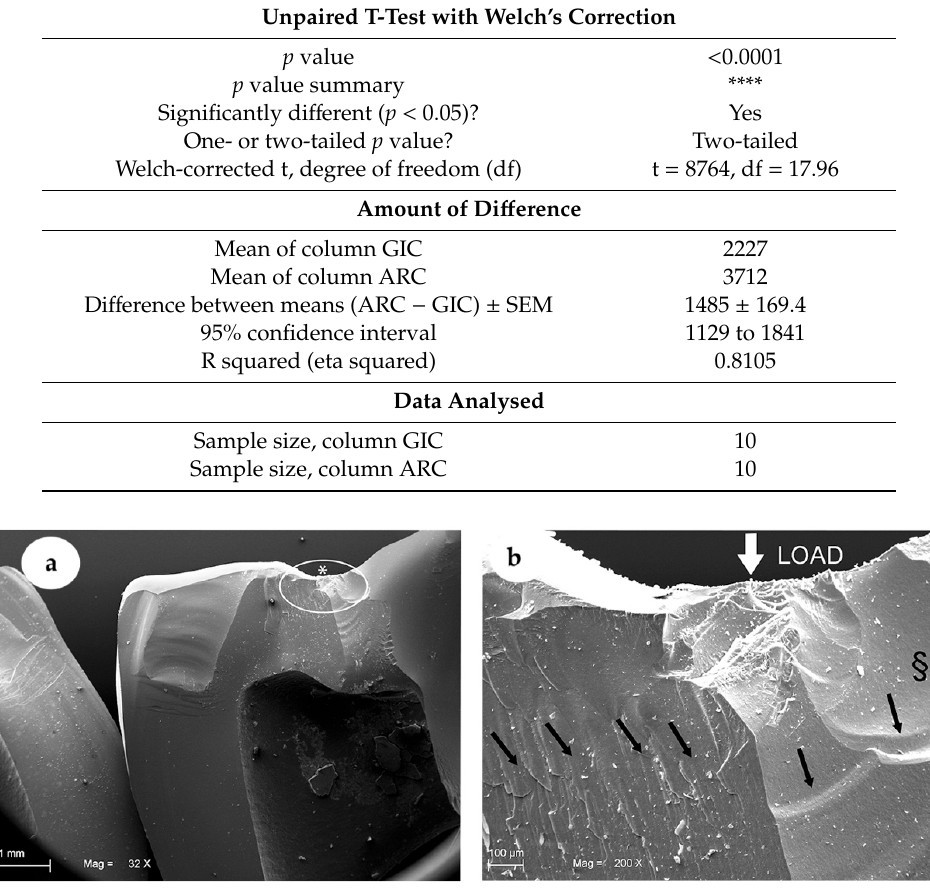
Figure 4. SEM images showing representative ZLS crown of ARC Group. In ( a ), (32× magnification) the fracture of ZLS crown is shown. The * indicates area showed at a higher magnification. It is possible to see the abutment attached to the crown in ( b ) (200× magnification). The white arrow shows the force application point. The § demonstrate the "mirror" areas near the point of load application. Moreover,a fracture surface with less "hackle" areas compared to GIC Group is shown, whilst the blackarrows indicated the direction of fracture propagation. 4. Discussion The null hypothesis under test was rejected, demonstrating that there was a statistically significant difference in terms of fracture strength due to the type of cementation used. Over the years, the mechanical and aesthetic characteristics of metal-free restorations have been widely evaluated. The introduction of the ZLS has made it possible to combine the excellent aesthetic performance of glass ceramics with the performance of zirconia. The marginal adaptation, translucency and yield following the aging process were assessed, positively evaluating the qualities of the material [40]. Considering the recent introduction of the ZLS material on the market, there are no long-term follow-ups studies available [41]. Despite this, some precautions during the delivery of the ZLS crowns can improve the performance of ceramic restorations. Among these, the role of the cementation technique is still controversial. Some authors have shown that the cementation technique does not affect the long-term yield of ceramic restorations [42]. On the contrary, other studies have shown how cementation can